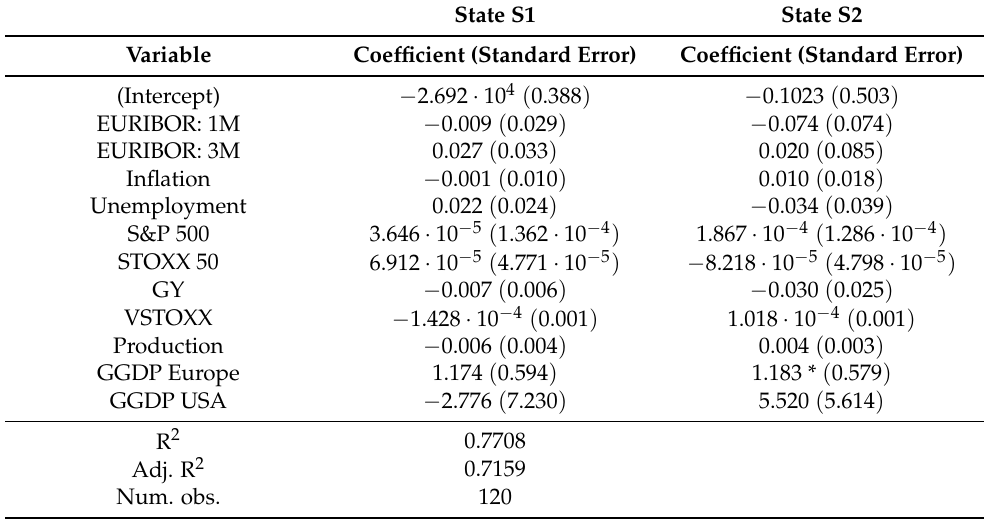
Table 8. Fitted regression model (8) with 2 Markov states before stepwise model